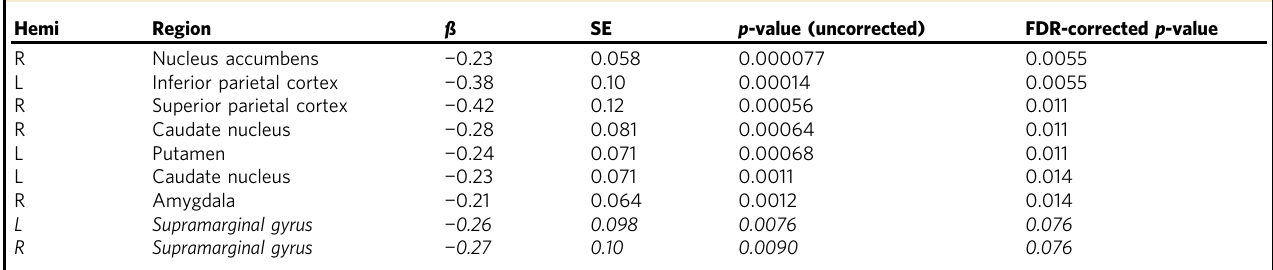
Regions where neural similarity was signi fi cantly predictive of social distance ( p < 0.05, FDR-corrected, two-tailed) are shown; marginally signi fi cant results ( p < 0.08) are italicized. Ordered logistic regression analyses were carried out for each brain region using multi-way clustering to account for dyadic dependencies in the data. Negative regression coef fi cients indicate that greater neural response similarity was associated with decreased social distance FDR false discovery rate, Hemi hemisphere, L left, R